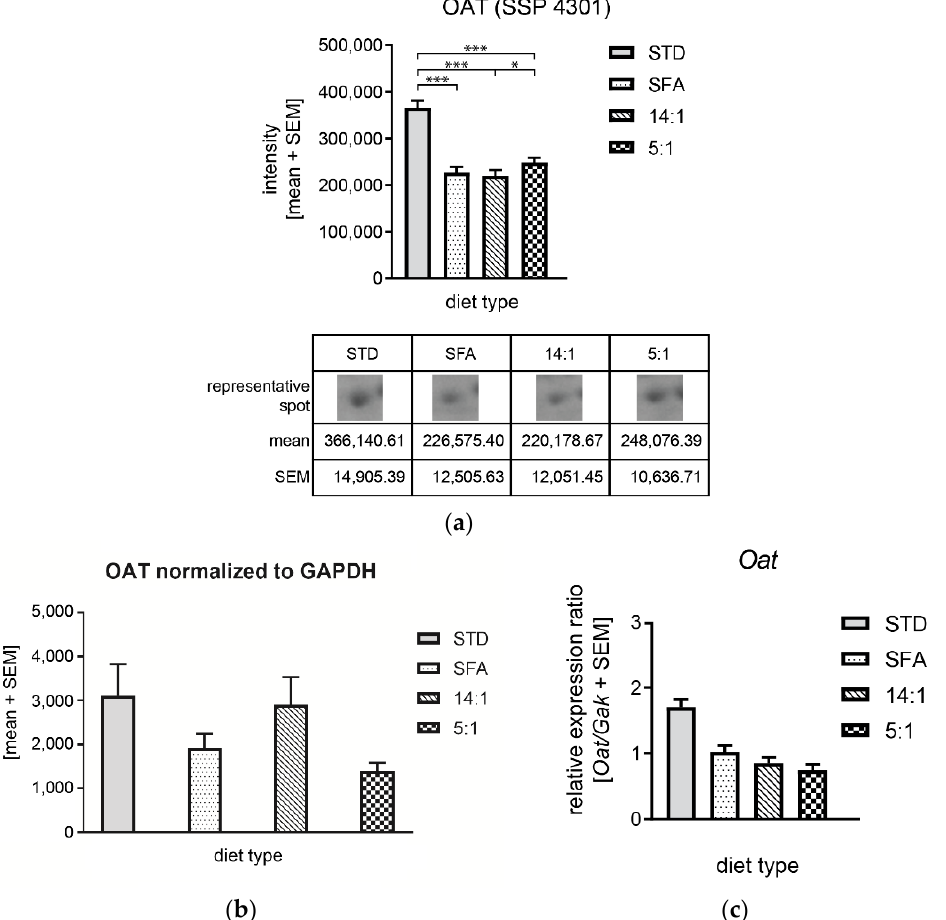
Figure 12. Alterations of OAT expression in response to different high-fat diets. ( a ) Protein levels based on 2DE; ( b ) Western blotting analysis using anti-OAT and anti-GAPDH antibodies and six mouse liver samples per group; signal intensities of OAT were normalized to GAPDH signal intensities. Graphs presented a mean intensity with a standard error of the mean (SEM); ( c ) Oat mRNA level normalized to Gak. *— p < 0.05; ***— p < 0.001.